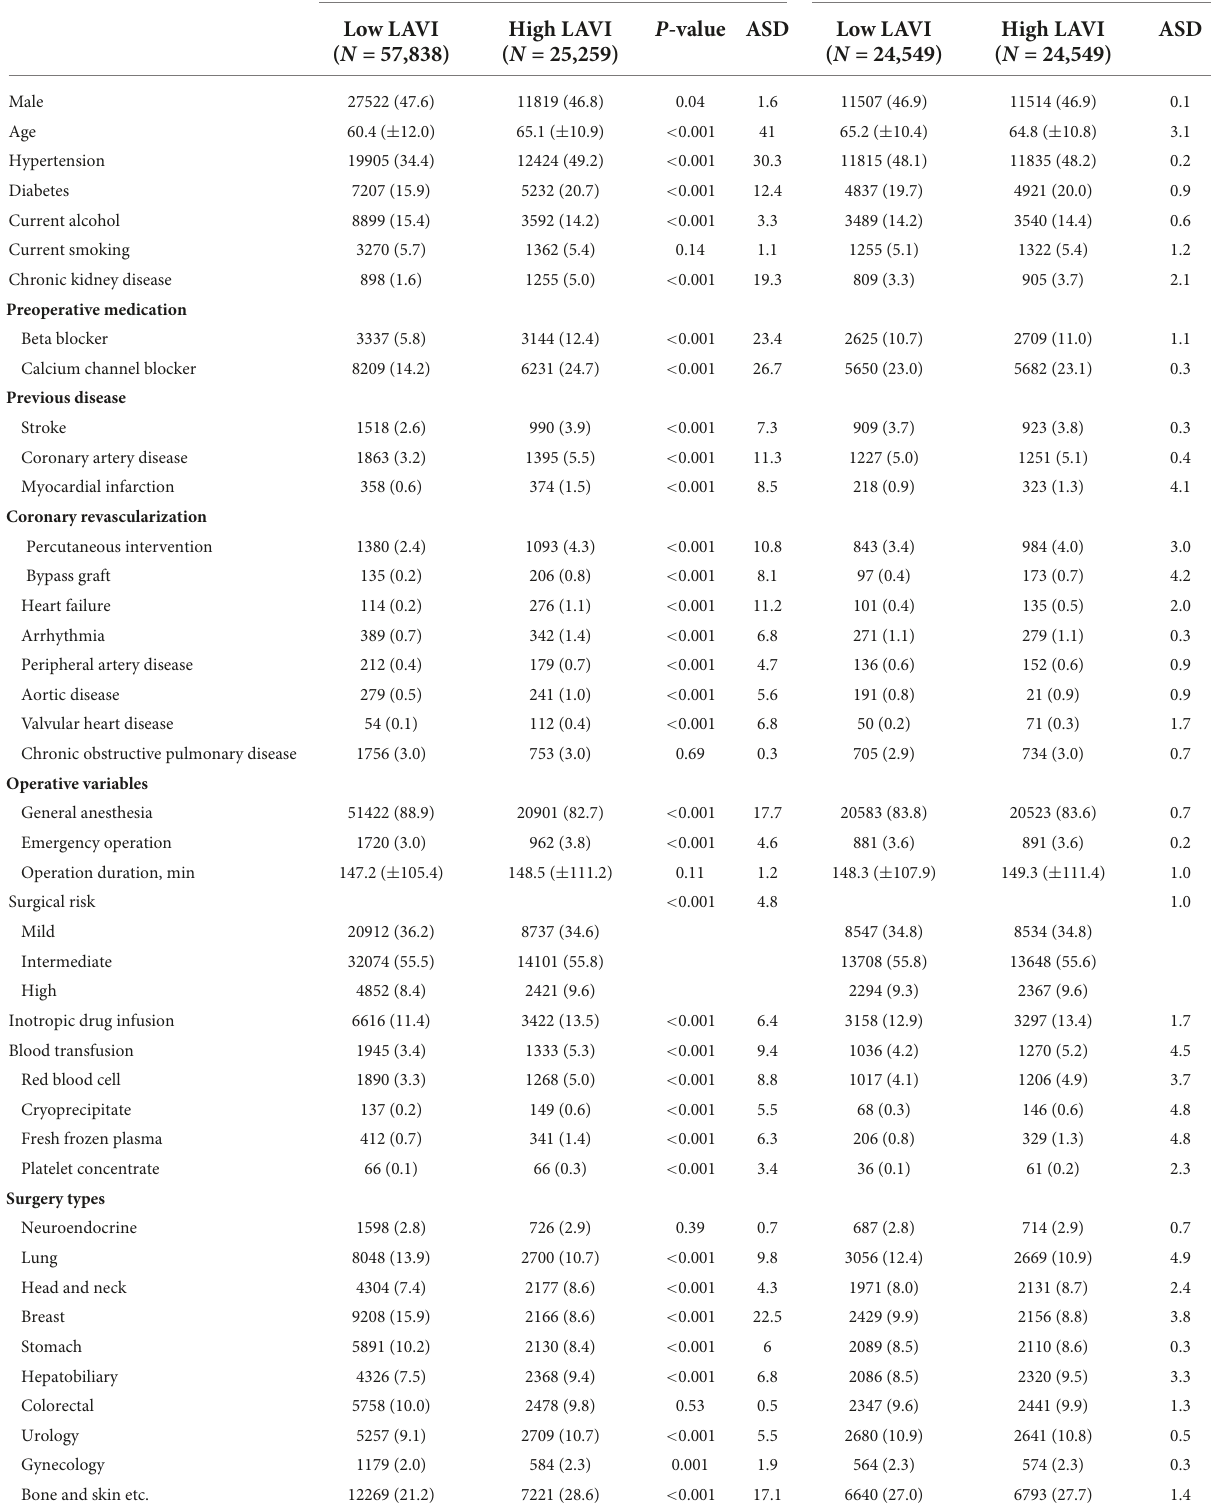
TABLE 1 Preoperative variables according to left atrial volume index